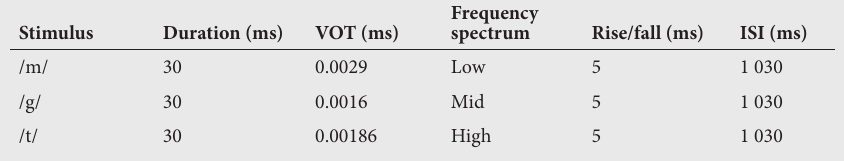
Table 1. Details of the stimuli, stimulus type, duration, VOT, rise/fall time, format frequency, and ISI